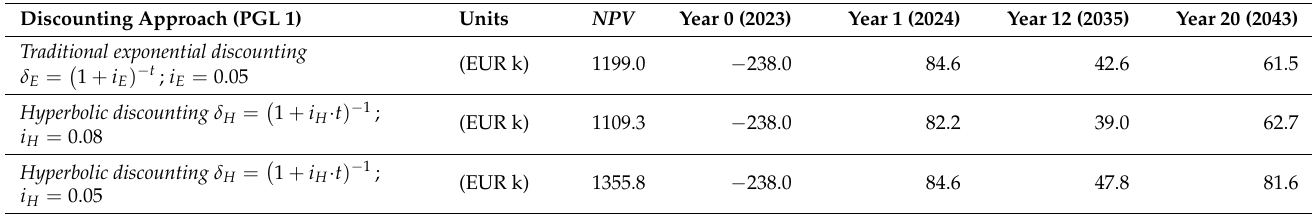
Table 3. Different discounting approaches to calculate the NPV